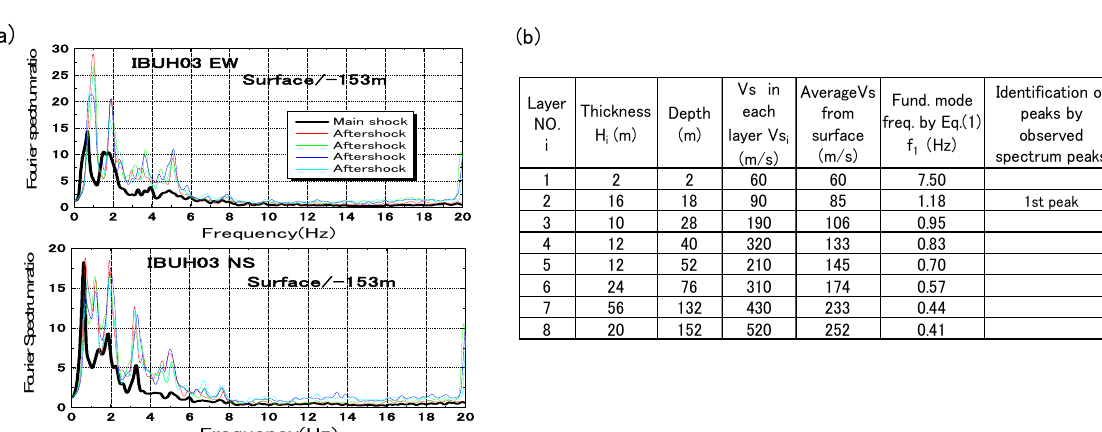
Figure 7. Fourier spectrum ratios of observed motions EW & NS ( a ), and Soil/ V s -profiles compared with spectrum peak frequency ( b ), at NMRH02 during EQ3.